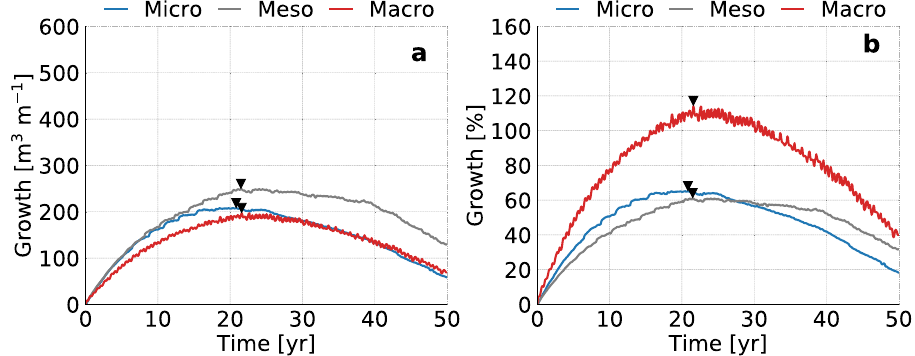
Figure 10. Simulated growth of fresh groundwater for micro (blue line), meso (dark grey line), and macro (red line) tidal ranges, where the black triangles point to the time with the maximum growth of fresh groundwater. The graphs represent the change in volume (left) and percentage (right) with respect to the initial conditions.